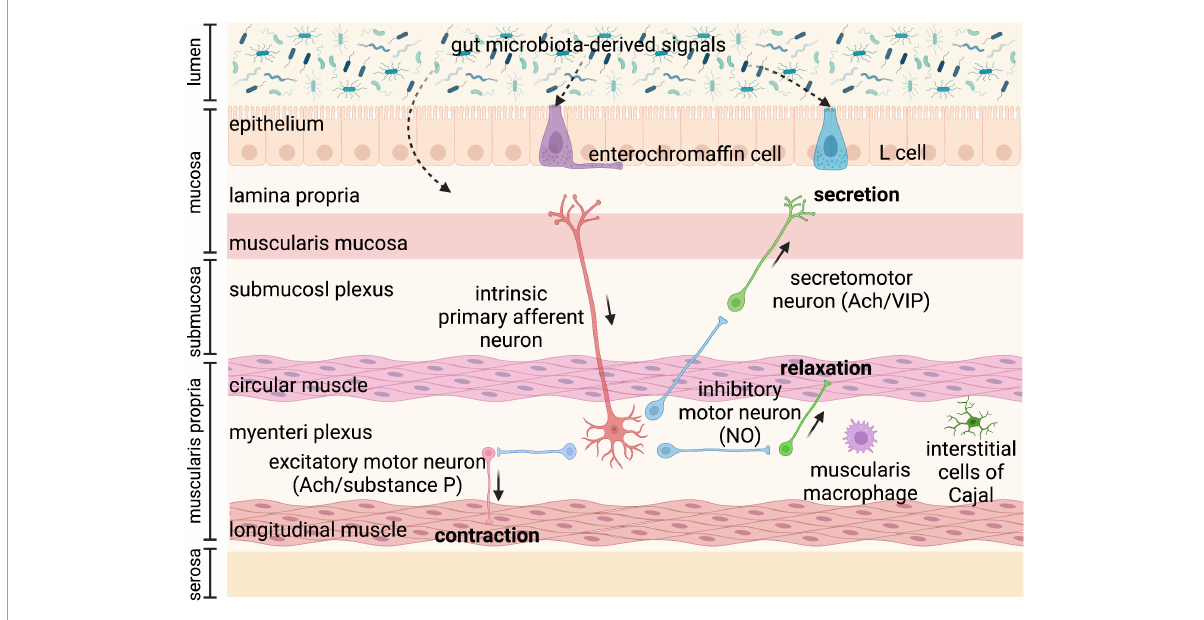
FIGURE1 Anatomy of the bowel wall ensures the effect of gut microbiota on gastrointestinal (GI) motility. Gut microbiota is geographically close to the bowel wall, which is composed of the mucosa layer (epithelium, lamina propria, and muscularis mucosa), the submucosa layer (submucosal plexus), the muscularis propria (circular smooth muscle, myenteric plexus, and longitudinal smooth muscle), and the serosa layer. Enteroendocrine cells (enterochromaffin cells and L cells) dispersed among the mucosa layer can directly sense gut microbiota-derived signals and then secrete hormones, such as glucagon-like peptides (GLPs) and peptide YY (PYY) (L cells), and serotonin (enterochromaffin cells), affecting enteric nervous system (ENS) and gastrointestinal (GI) motility. The ENS comprising submucosal plexus and myenteric plexus plays a central role in GI motility and can also sense and respond to gut microbiota-derived stimuli that cross the epithelium. The myenteric plexus is responsible for the propulsion of intestinal contents under the movement of the smooth muscle, while the submucosal plexus is mainly involved in the secretion and absorption. Intrinsic primary afferent neurons (IPANs) are activated by gut-derived signals and activate ascending and descending interneurons, which stimulate inhibitory and excitatory motor neurons, as well as secretomotor neurons. Besides, musculari macrophage and interstitial cells of Cajal (ICCs) in muscularis propria can be activated by gut microbiota-derived signals affecting GI motility. Ach, acetylcholine; NO, nitric oxide; VIP, vasoactive intestinal